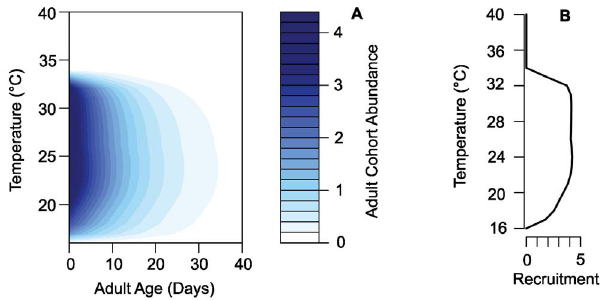
Figure 3. Age-specific adult abundance and adult recruitment across temperature. (A) The age-specific abundance of a single cohort of adult mosquitoes for each temperature. High abundance is in dark blue decreasing to zero in white. (B) Recruitment (the mean abundance of new recruits) into the adult stage over the temperature range.